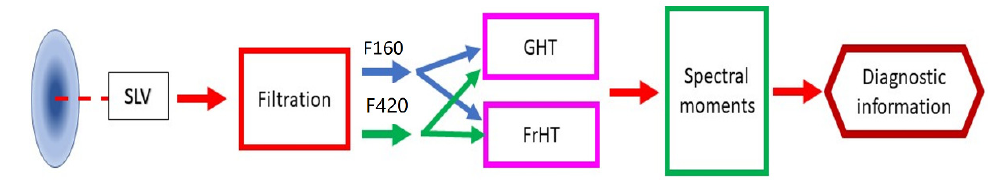
Figure 4. Diagram of the Method.